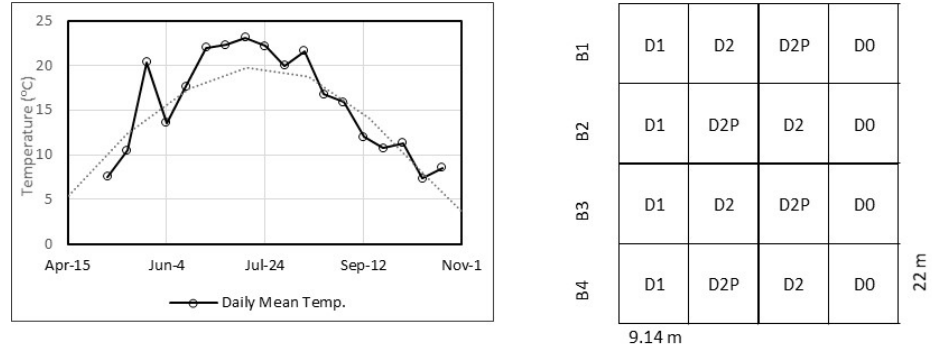
Figure 6. Daily temperature 10-day average for the 2020 season and climate norm 1981–2010, and schematic diagram of the experimental setup.